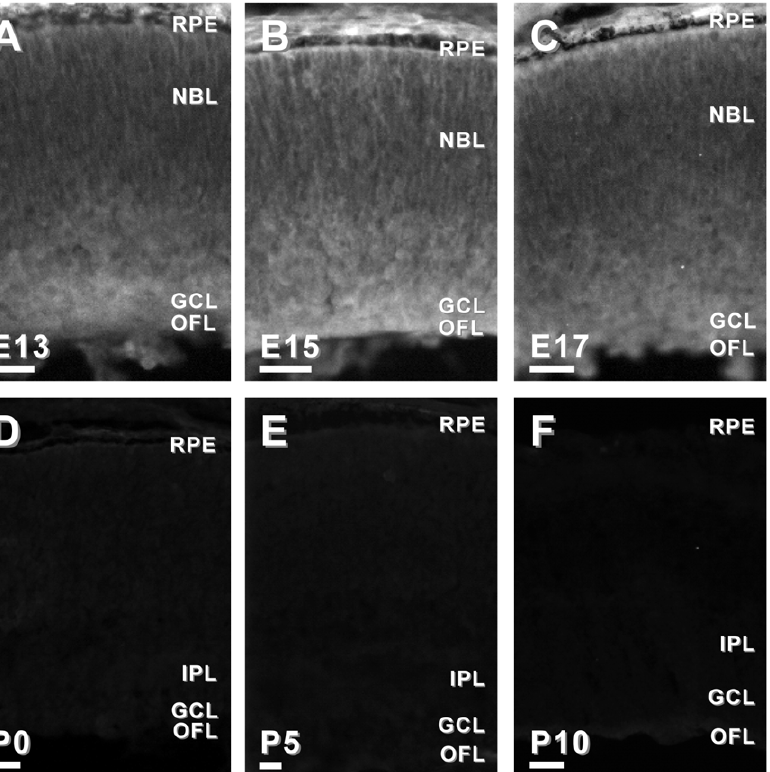
Figure 5. Dynamic protein expression of Psme1 in developing mouse retina. PSME1-IR in the E13 mouse retina was diffusely distributed throughout the E13, E15 and E17 retinas (A–C). However, by P0, PSME1-IR was no loner detectable above background (D). Similarly, no PSME-IR was detected in the P5 or P10 retinas (E, F). Abbreviations same as in Figure 2. Bars, 30 m m.